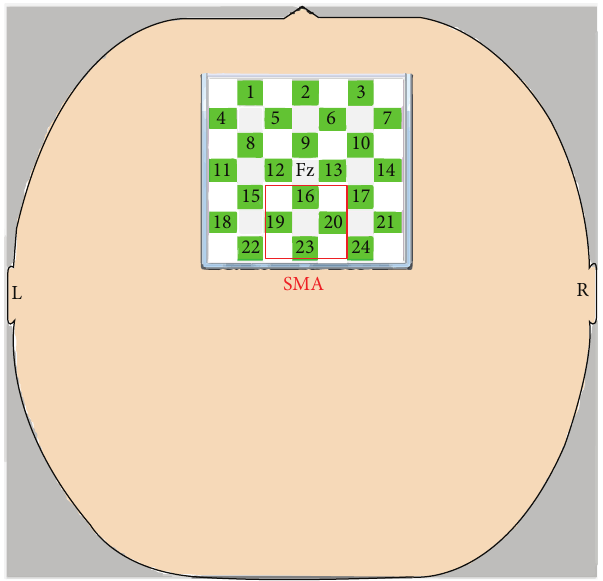
Figure 1: Near-infrared spectroscopy probe settings. The supple- mentary motor area (SMA) was covered by channels 16, 19, 20, and 23 within the red